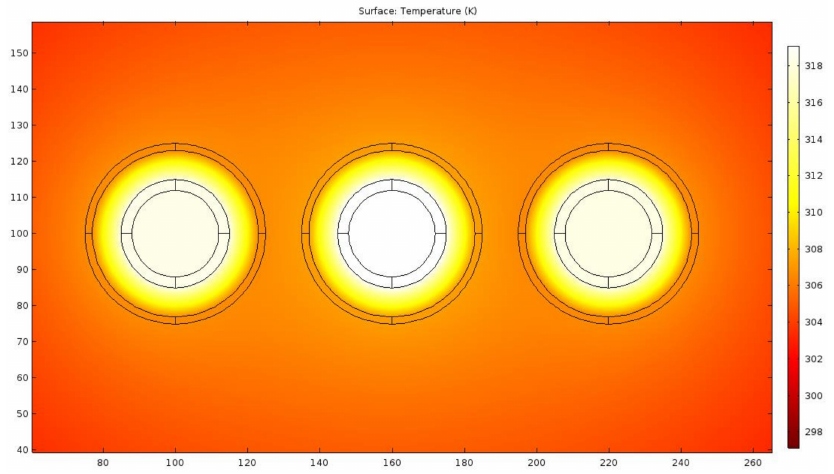
Figure 6. Temperature distribution in the three-phase high-current